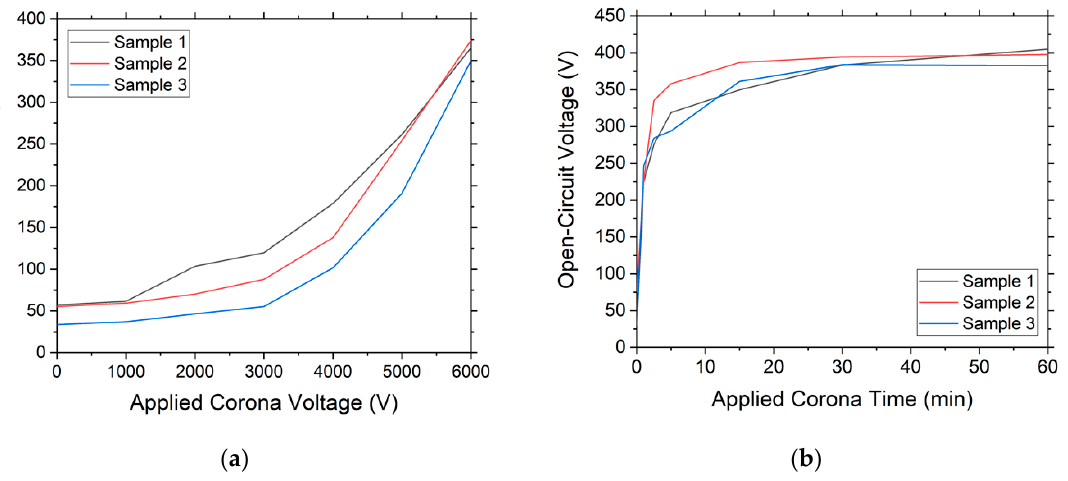
Figure 4. ( a ) Charge injection setup using high voltage corona charging; ( b ) schematic of the process of charge injection by corona.